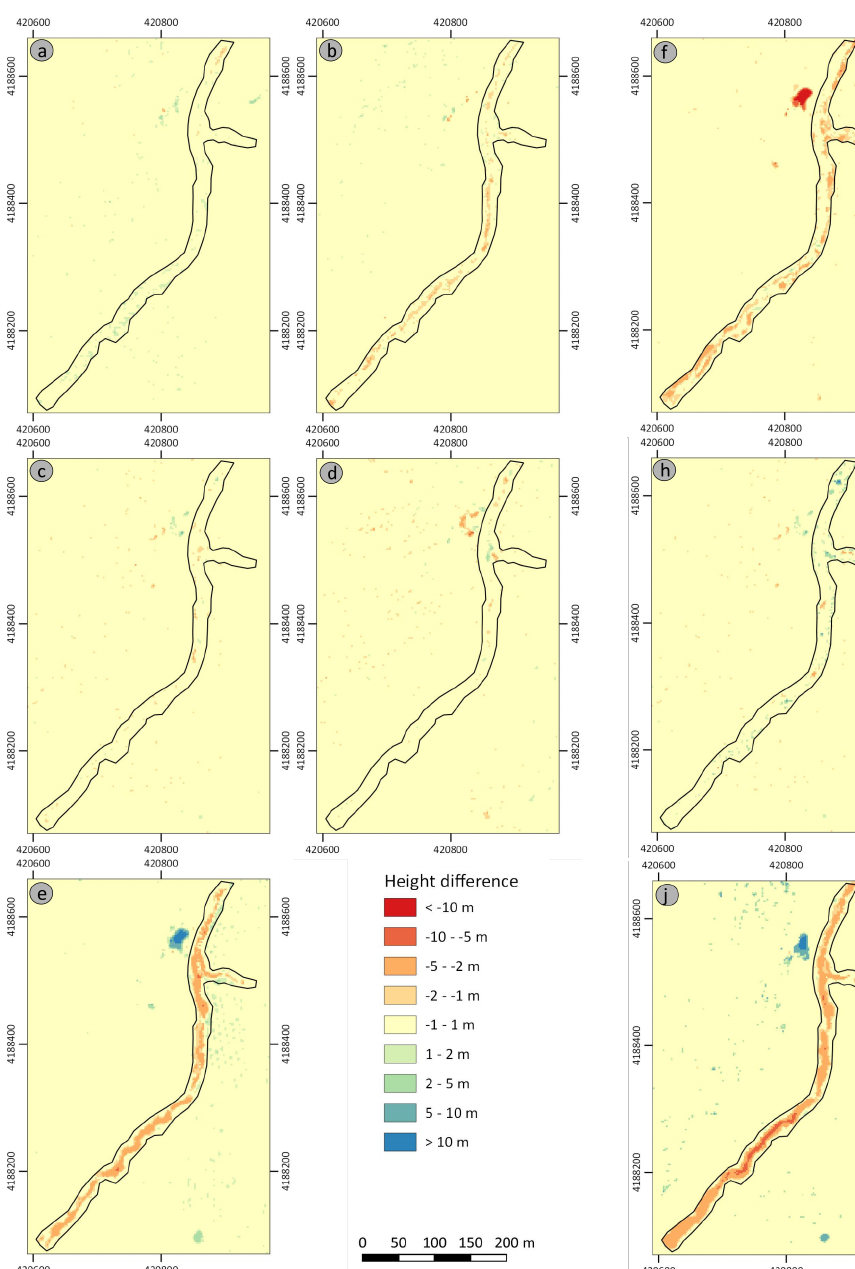
Figure 3. DoDs of the study area: a: 1980-1996; b: 1996-2001; c: 2001-2005; d: 2005-2009; e: 2009-2011.